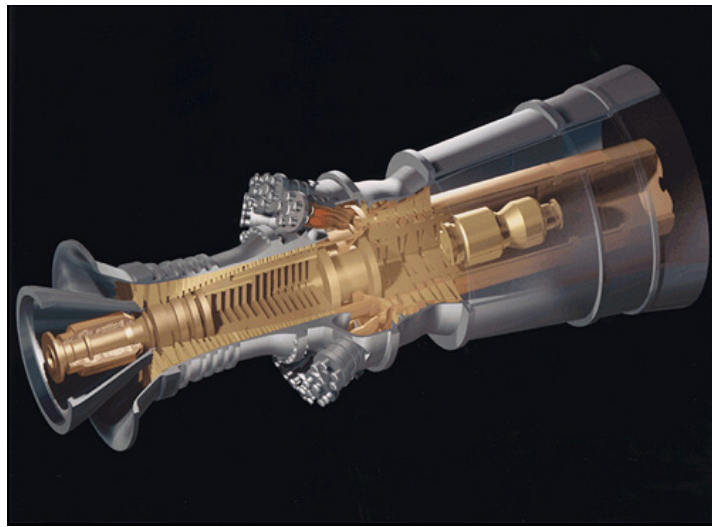
Figure 1. GE H-series power generation gas turbine [16].